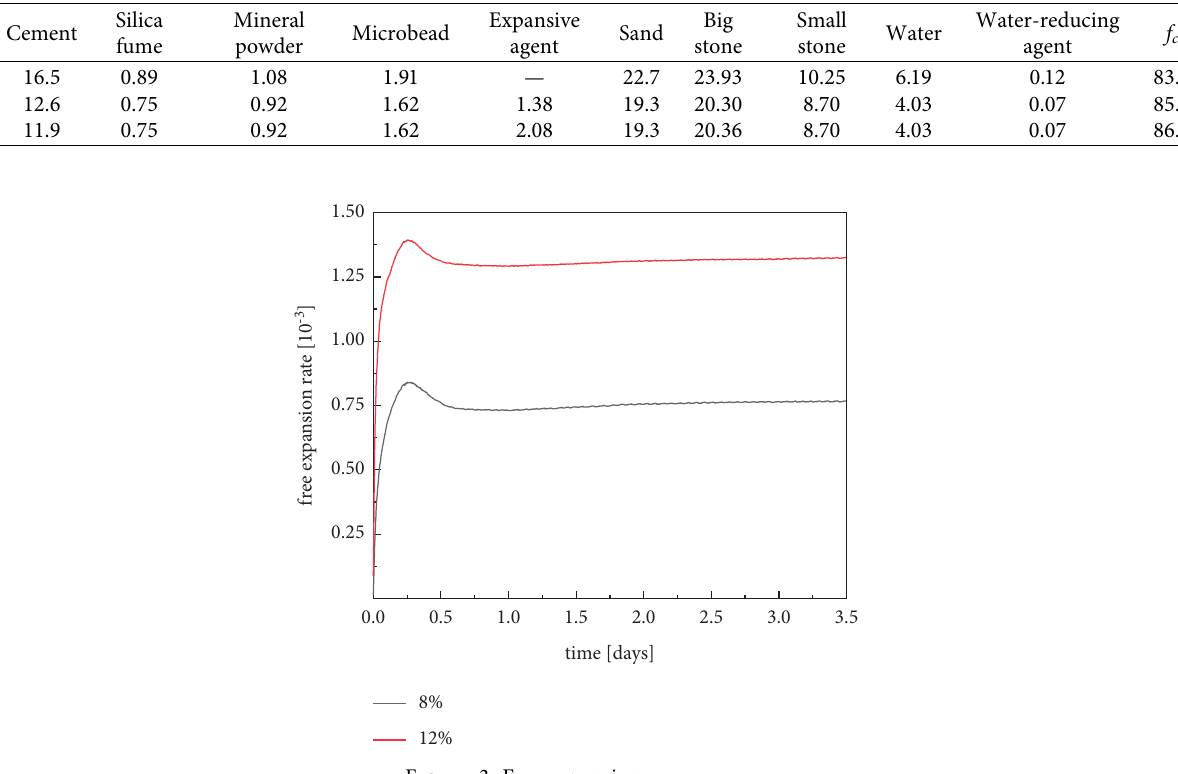
Table 2: Mix design of microexpansive concrete